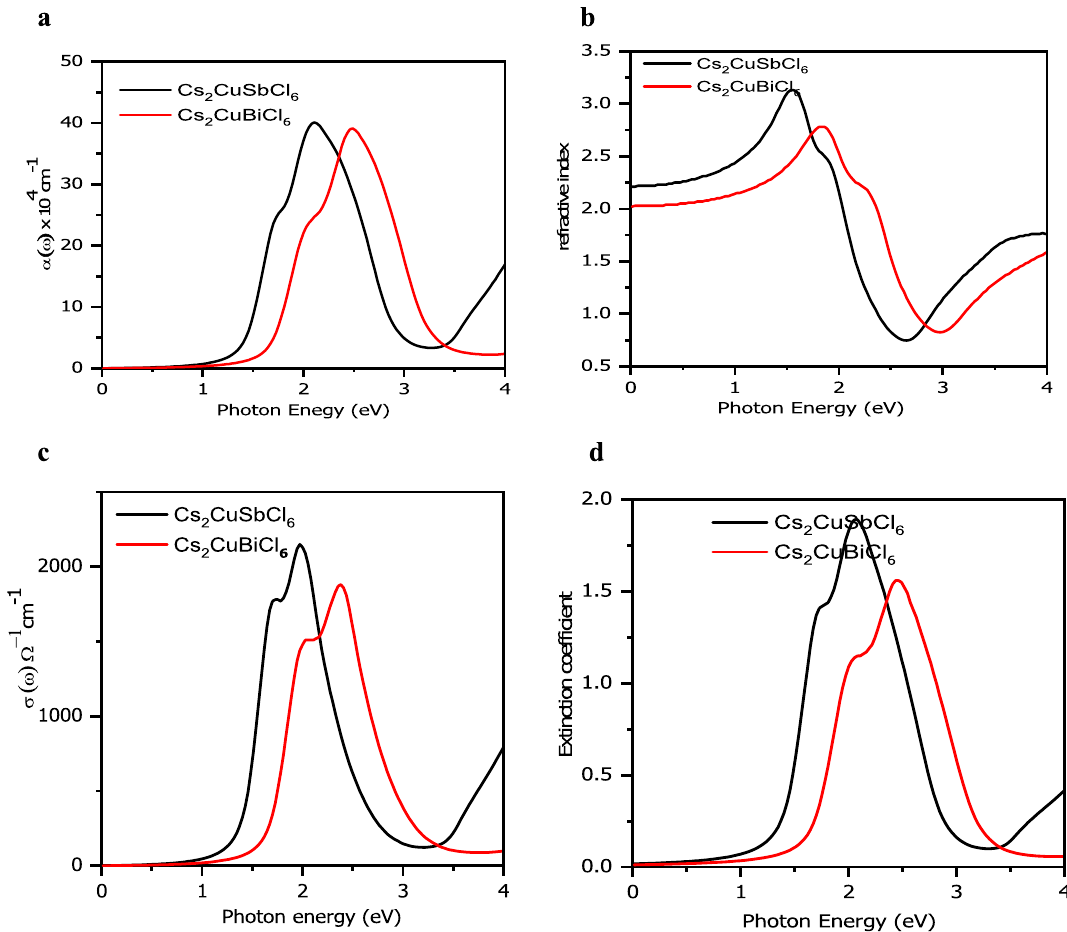
Figure 7. The various optical parameters calculated by GGA + mBJ approximation for Cs 2 CuSbCl 6 and Cs